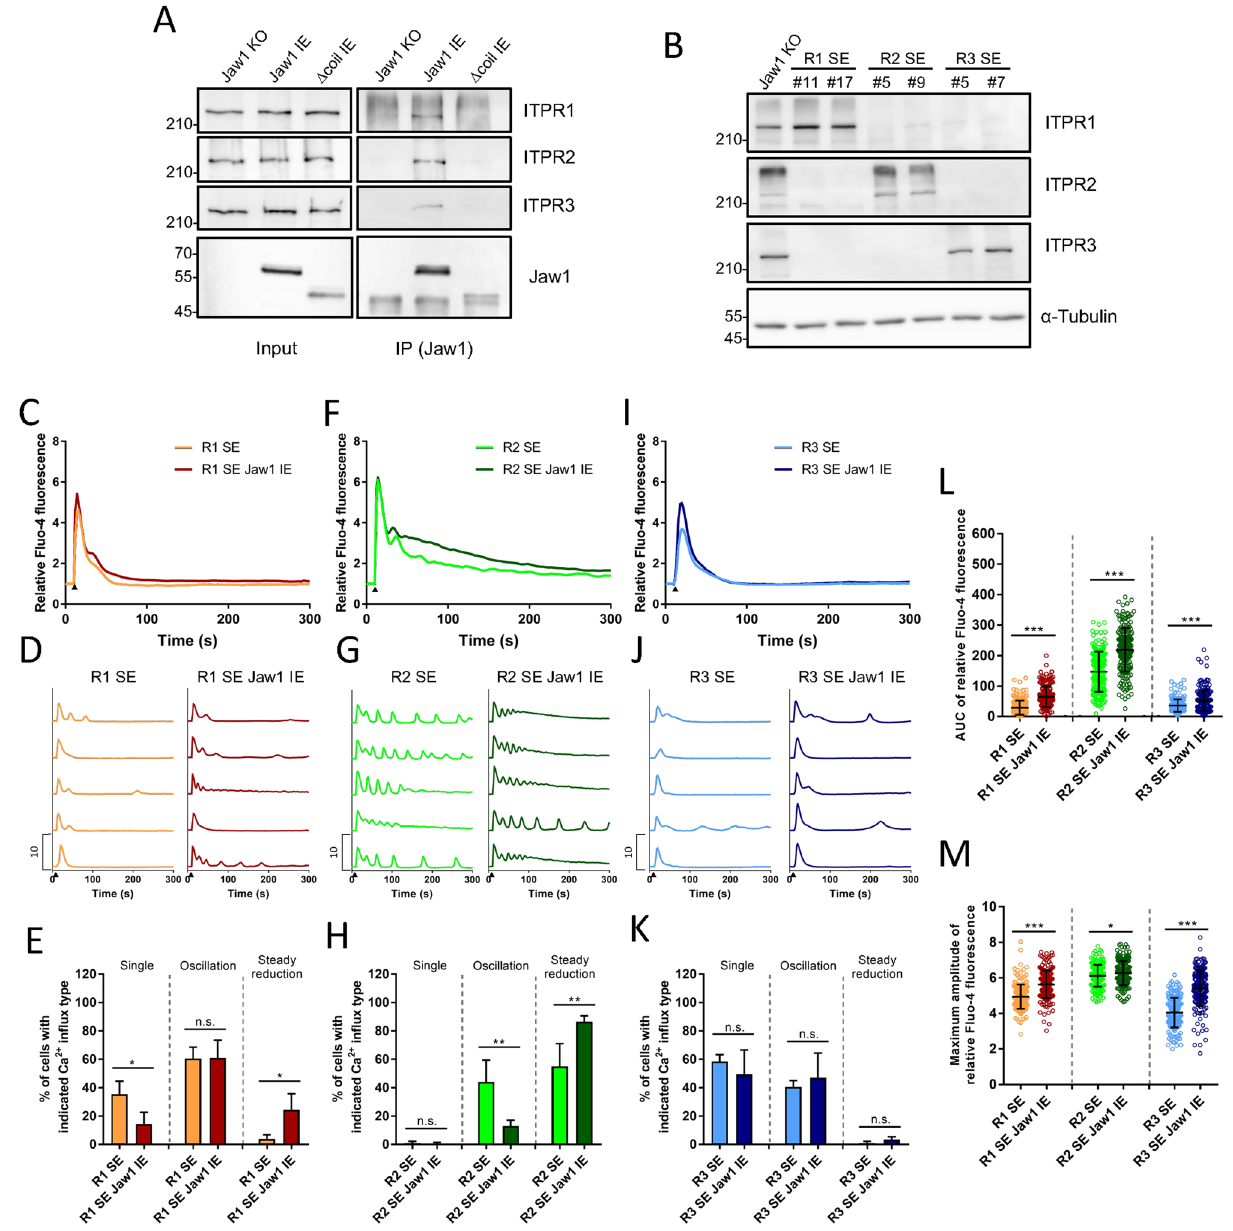
Figure 5. Jaw1 increases the activity of all ITPR subtypes with subtle differences. ( A ) Jaw1 KO, Jaw1 IE, and Δcoil IE cell lysates were subjected to co-immunoprecipitation followed by western blotting. ( B ) Jaw1 KO, R1 SE #11 or #17, R2 SE #5 or #9, and R3 SE #5 or #7 cells were subjected to western blotting. Images used for western blots of ( A ) and ( B ) are shown in Supplementary Fig. S5, S6 online. ( C , D , F , G , I , J ) Mean ( C , F , I ) or five representative ( D , G , J ) curves of the relative intensity in R1 SE, R2 SE, and R3 SE with or without Jaw1 IE cells. Closed triangles indicate the time point of 100 µM ATP solution supplementation. n = 200. ( E , H , K ) Classification of the Ca 2+ influx type in each cell line. Four independent experiments (n = 50). ( L , M ) AUC ( L ) or maximum amplitude ( M ) of the relative intensity from ( C ), ( F ), and ( I ). The error bar shows ± S.D.; n.s., non- significant; * p < 0.05; ** p < 0.01; *** p <